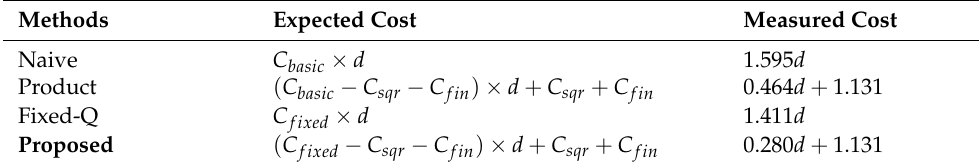
Table 2. Execution times of the inner-pairing product computation for various